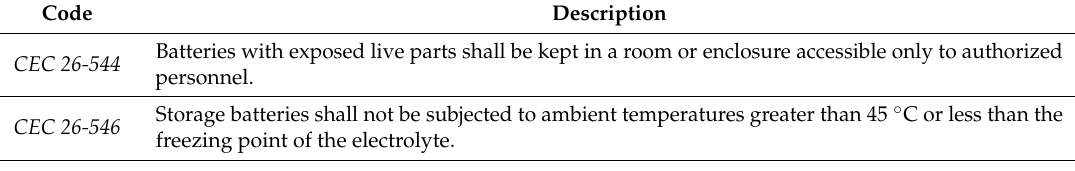
Table 3. Applicable codes for re-purposed Li-ion battery Canadian electrical